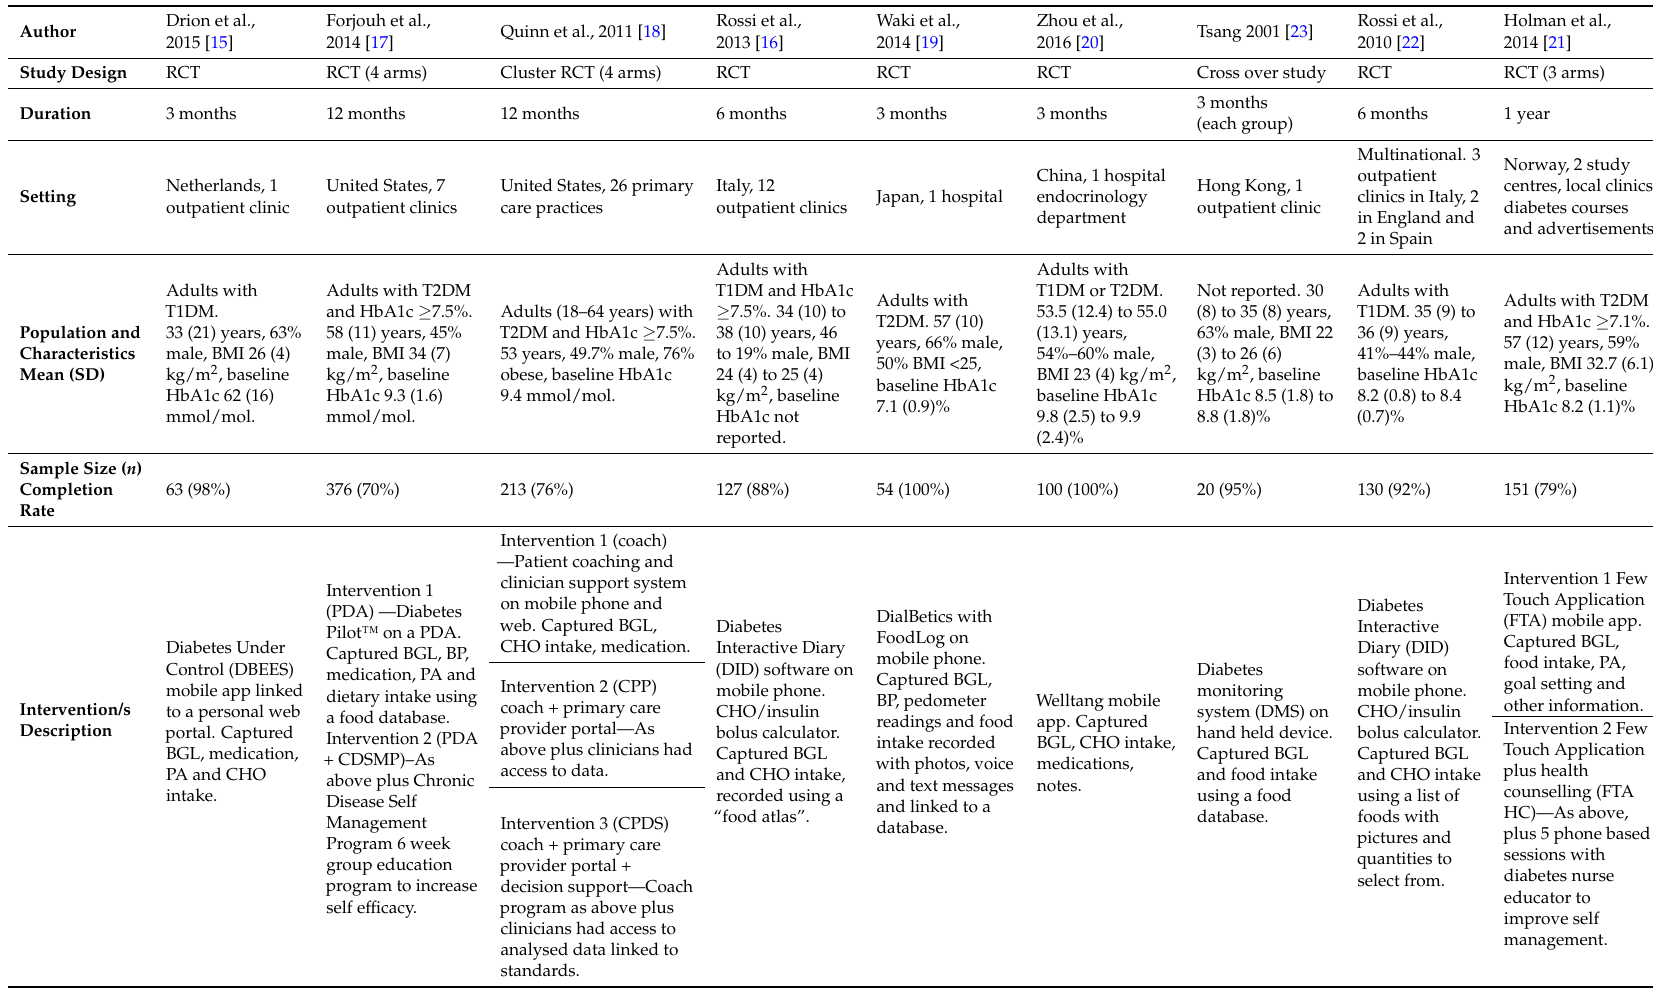
Table 1. Key characteristics and primary outcome data of studies comparing the effect of using mobile devices to record food or nutrition intake to usual care on diabetes control and nutrition